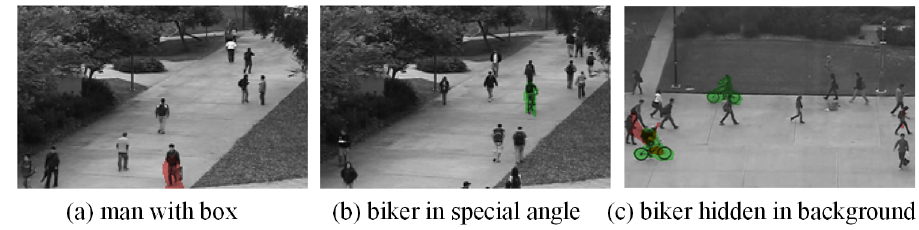
Figure 8. Examples of failure results on Ped1 and Ped2 sequences. The detection results are marked with red color and the groundtruth are with green